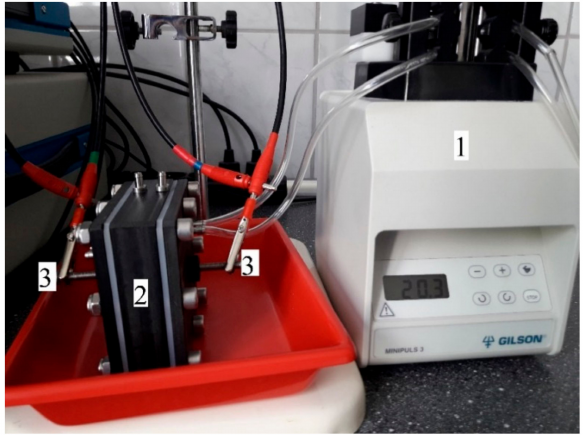
Figure 8. A single-cell electrolyzer unit employed for the 8-h electrolysis trials: 1—Gilson Minipuls 3 peristaltic pump; 2—electrolyzer unit; 3—electrical